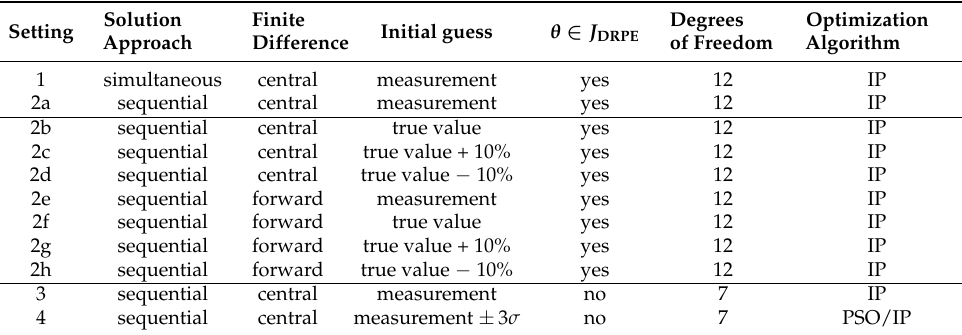
Table 3. Configuration settings of simulation